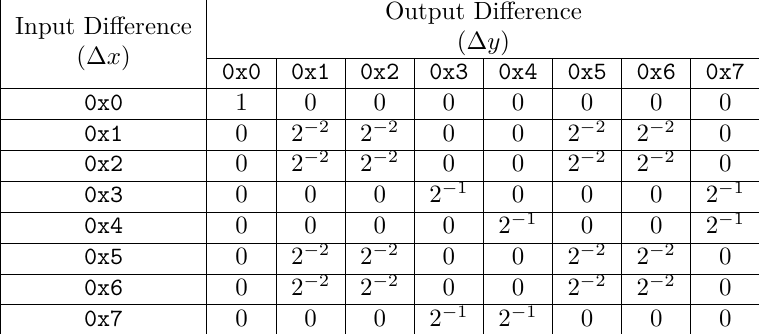
Table 4: The DDT of the 3-bit S-box given in Table 1